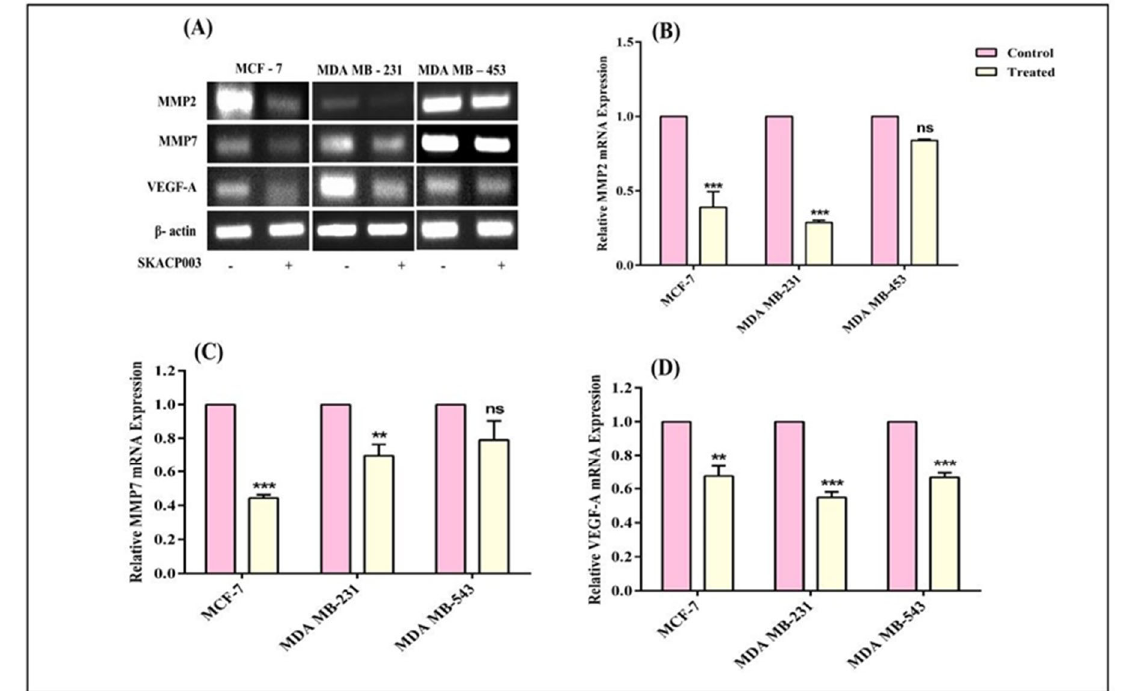
Figure 4. Inhibition of metastasis and angiogenesis by SKACP003. The mRNA levels of MMP-2 ( B ), MMP-7 ( C ), and VEGF-A ( D ) from total RNA were analyzed by RT-PCR ( A ) for the control and SKACP003-treated breast cancer cell lines of MCF-7, MDA-MB-231, and MDA-MB-453. ** = statistical significance at p < 0.01; *** = statistical significance at p < 0.001; ns = not significant.